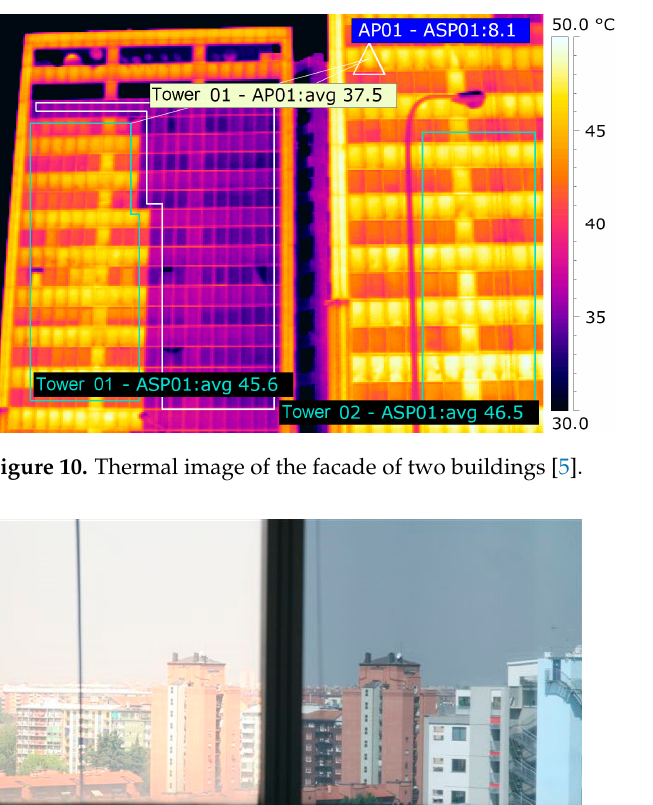
Figure 10. Thermal image of the facade of two buildings [5].